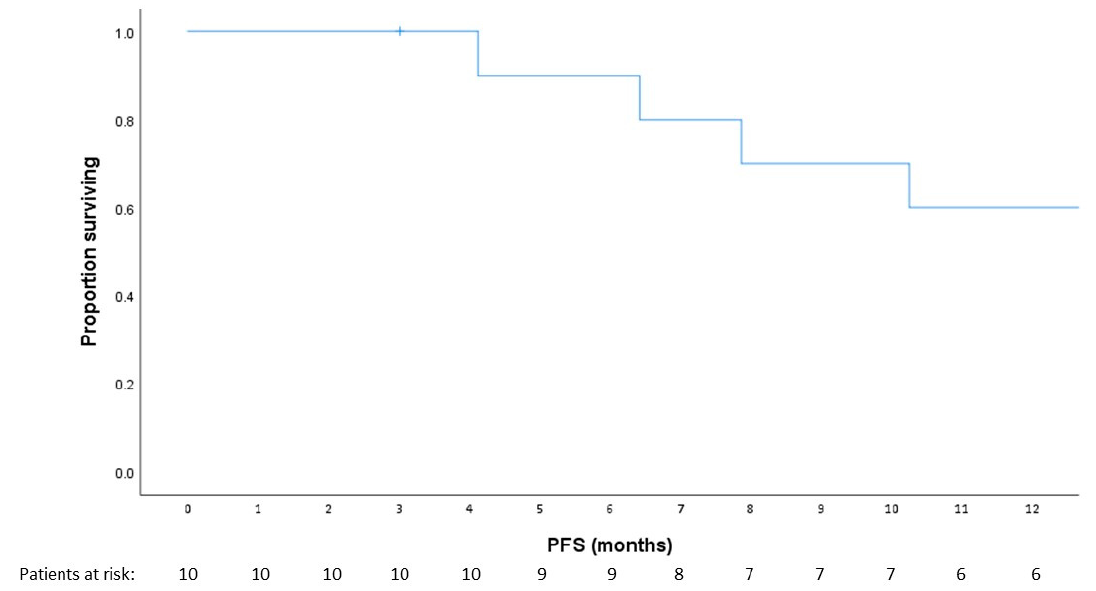
Figure 4. Progression-free survival (PFS). Kaplan–Meier curve demonstrating PFS in patients on trial.